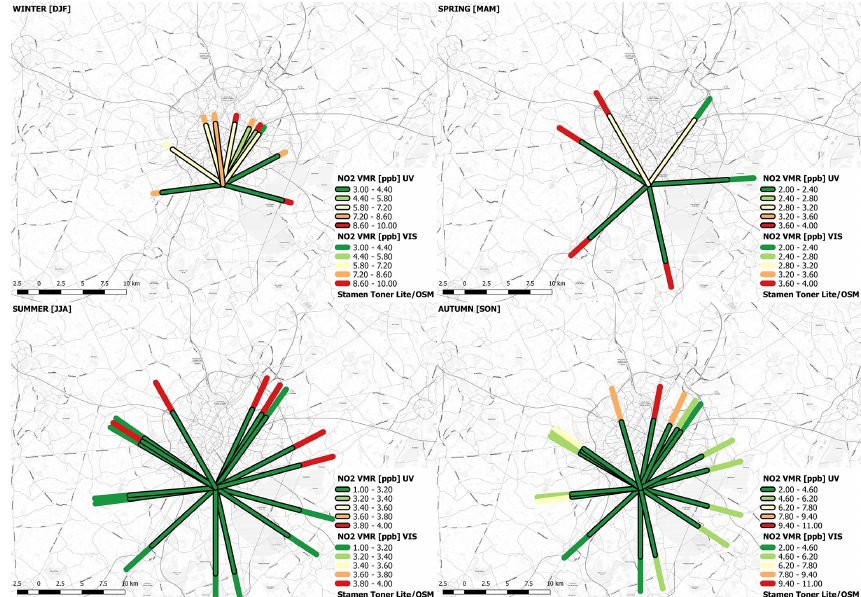
Figure 9. Seasonally averaged near-surface NO 2 VMR around 11:00UTC as a function of azimuthal viewing direction derived by the parameterization technique in the visible and UV wavelength ranges. Lines with black borders represent the UV VMRs, and lines without black borders show the visible VMRs. The length of each line represents the seasonally averaged horizontal sensitivity. Different color scales are used per season. © OpenStreetMap contributors 2019. Distributed under a Creative Commons BY-SA